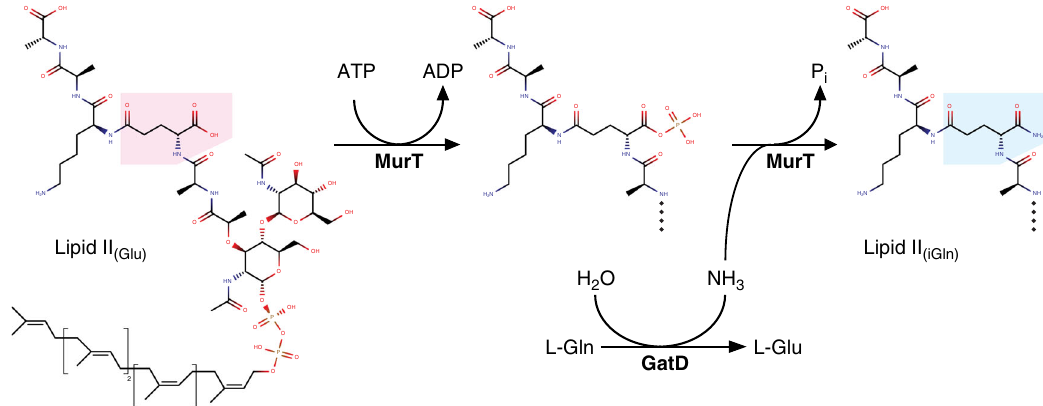
Fig. 1 Proposed reaction scheme of the lipid II amidation by MurT/GatD. The second residue of the pentapeptide is highlighted in pink (D-Glu) or blue (D- iso-Gln). The putative phosphorylated intermediate is also